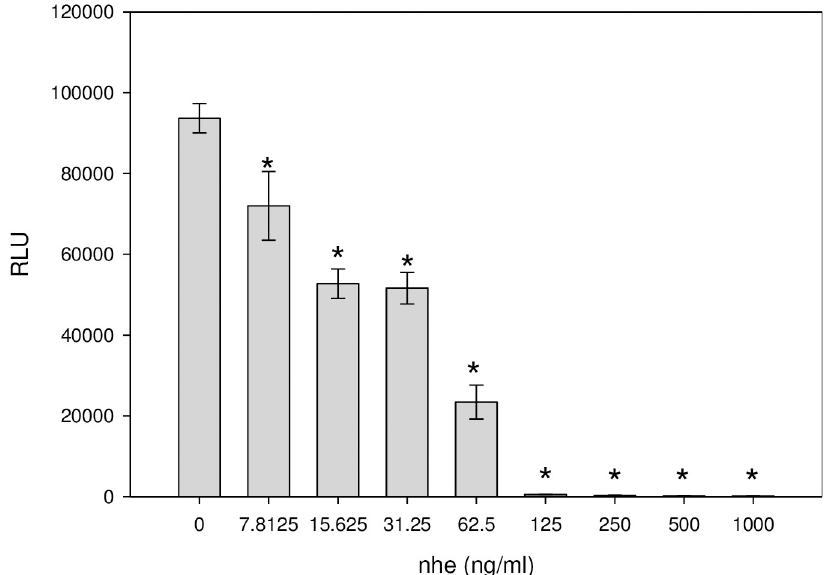
Fig 1. Determination of the biological activity of Nhe by measuring the decrease in light from the luciferase reaction as a result of inhibition of luciferase enzyme synthesis. Transduced Vero cells with adenoviral vectors that express the luciferase gene (Ad-Luc) were incubated with various concentrations of Nhe. The photon emission was detected by Bio Tek plate reader measured as relative light units. Values significantly different (P < 0.05) from control without Nhe are marked with an asterisk. Error bars represent standard